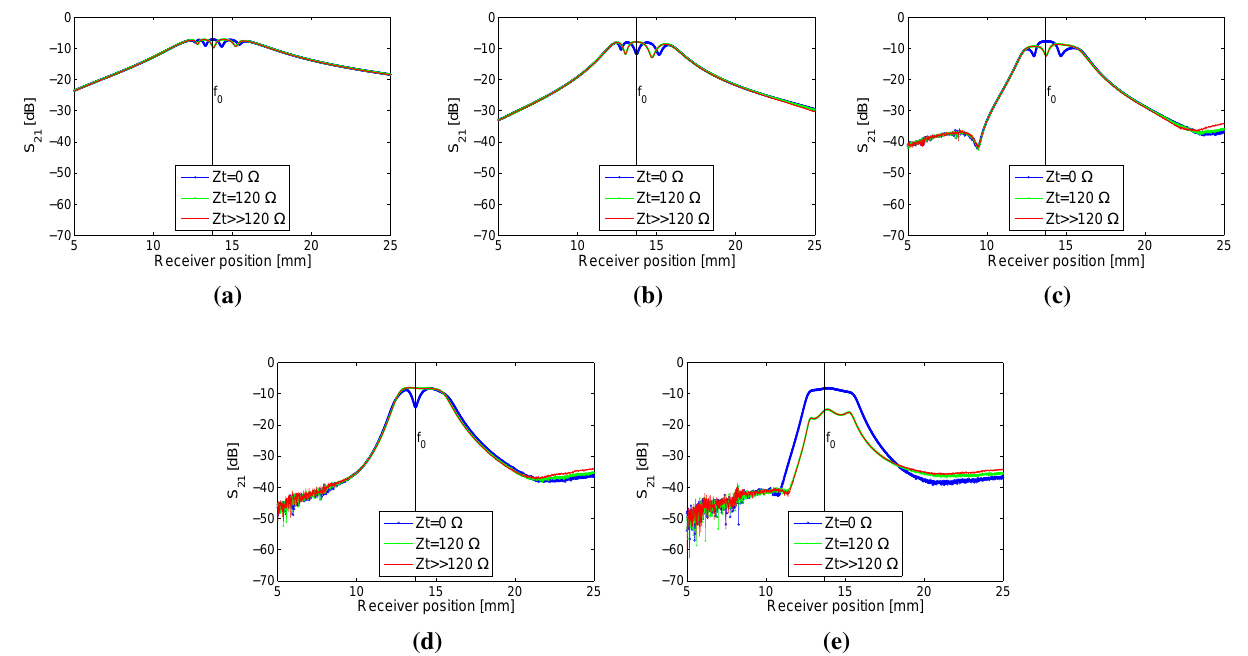
Figure 9. S measured as a function of frequency for all receiver positions facing the I ( a ), 21 II ( b ), III ( c ), IV ( d ) and V ( e ) cell.